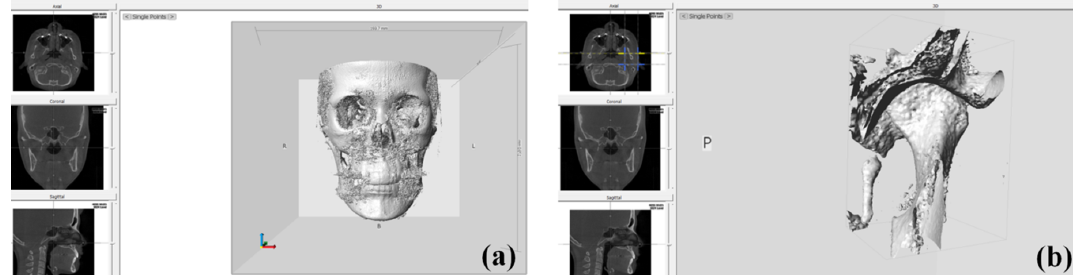
Figure 4. The view of Checkpoint (Stratovan): ( a ) imported CBCT data that were exported in DICOM format, ( b ) cropped volume isolating the left condyle-fossa unit.